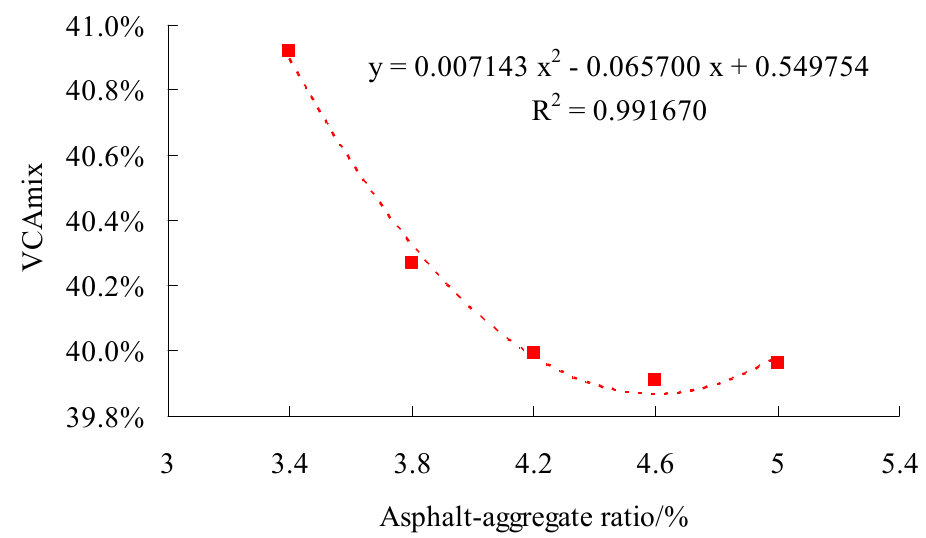
Figure 9. Test results of VCA mix at different asphalt—aggregate ratios.